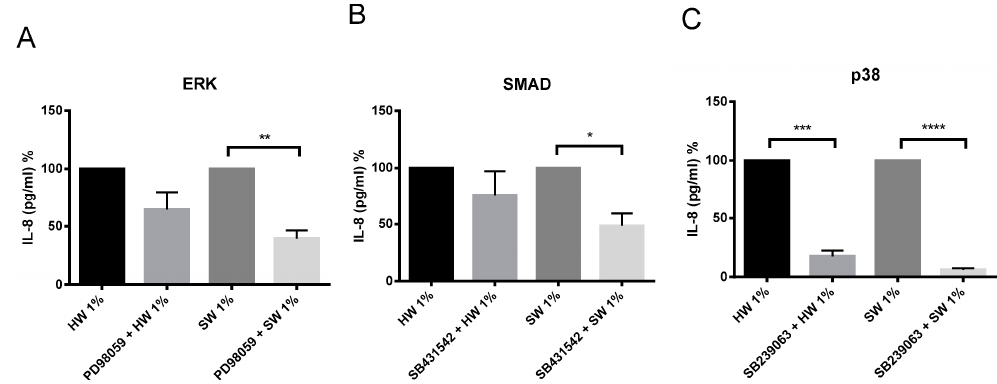
Figure 7. The effects of ERK ( A ), SMAD ( B ), and p38 MAP kinase ( C ) inhibitors on IL-8 production by hardwood and softwood smoke extract. Primary human lung fibroblasts ( n = 4) were pretreated for an hour with signaling inhibitors, PD98059 (10 µM), SB431542 (10 µM), and SB239063 (3 µM) in DMSO (vehicle control) for ERK, SMAD, and p38 MAP kinase pathway respectively, then stimulated with 1% hardwood and softwood smoke extract for 24 h. Supernatant was collected and IL-8 concentration analysis was executed via ELISA. Data expressed as the percent of inhibition from control and bars represent mean ± SEM. Statistical analysis executed by using repeated measures, one-way ANOVA with Tukey’s post-test. Significance is represented as * p < 0.05, ** p < 0.01, *** p < 0.001, **** p < 0.0001